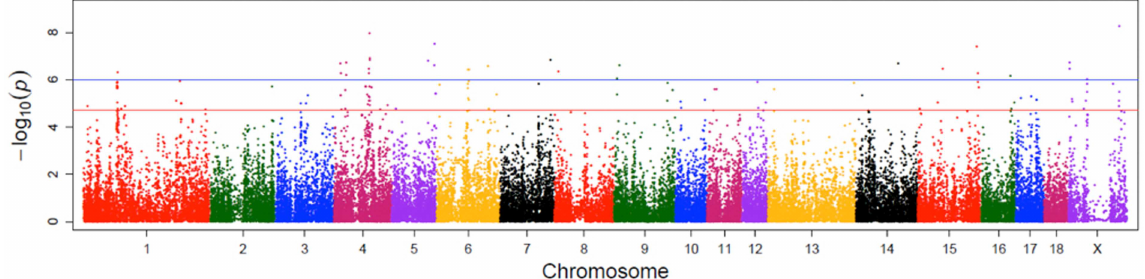
Fig 1. Manhattan plot of the genome-wide association analysis of EBV FCR. The red and blue lines indicatethe suggestive (-log10[p-value] (cid:21) 4.7) and the Bonferroni-adjusted genome-wide significancethreshold (-log10[p-value] (cid:21) 6), respectively.